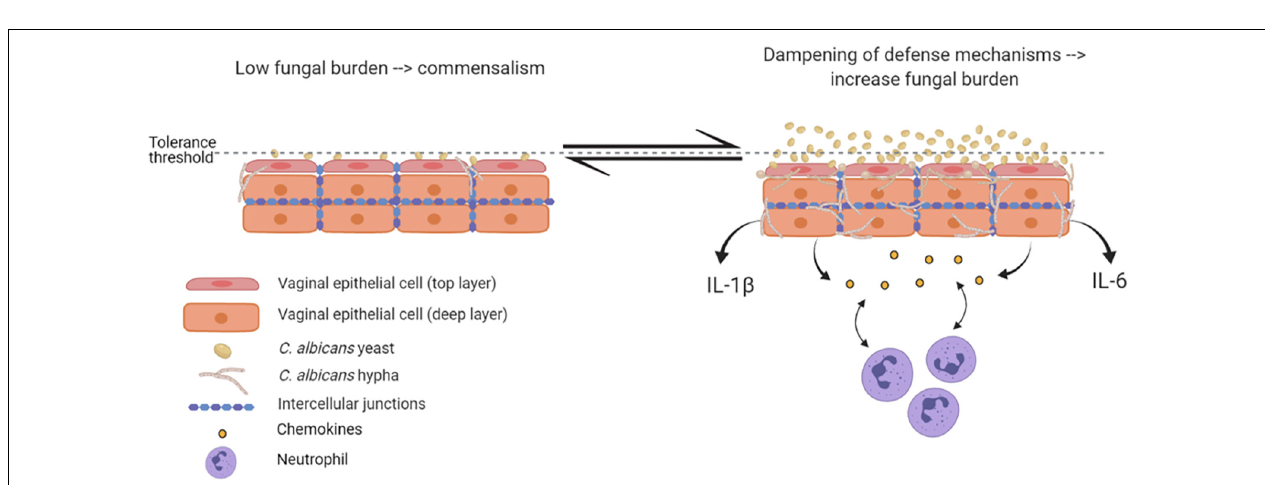
FIGURE 1 | Role of epithelial shedding in restraining C. albicans invasion of the vaginal mucosa. The exfoliation of the top layer of epithelial cells into the vaginal lumen (epithelial shedding), restrains vaginal mucosa invasion by C. albicans , therefore limiting the fungal burden (created with BioRender.com).